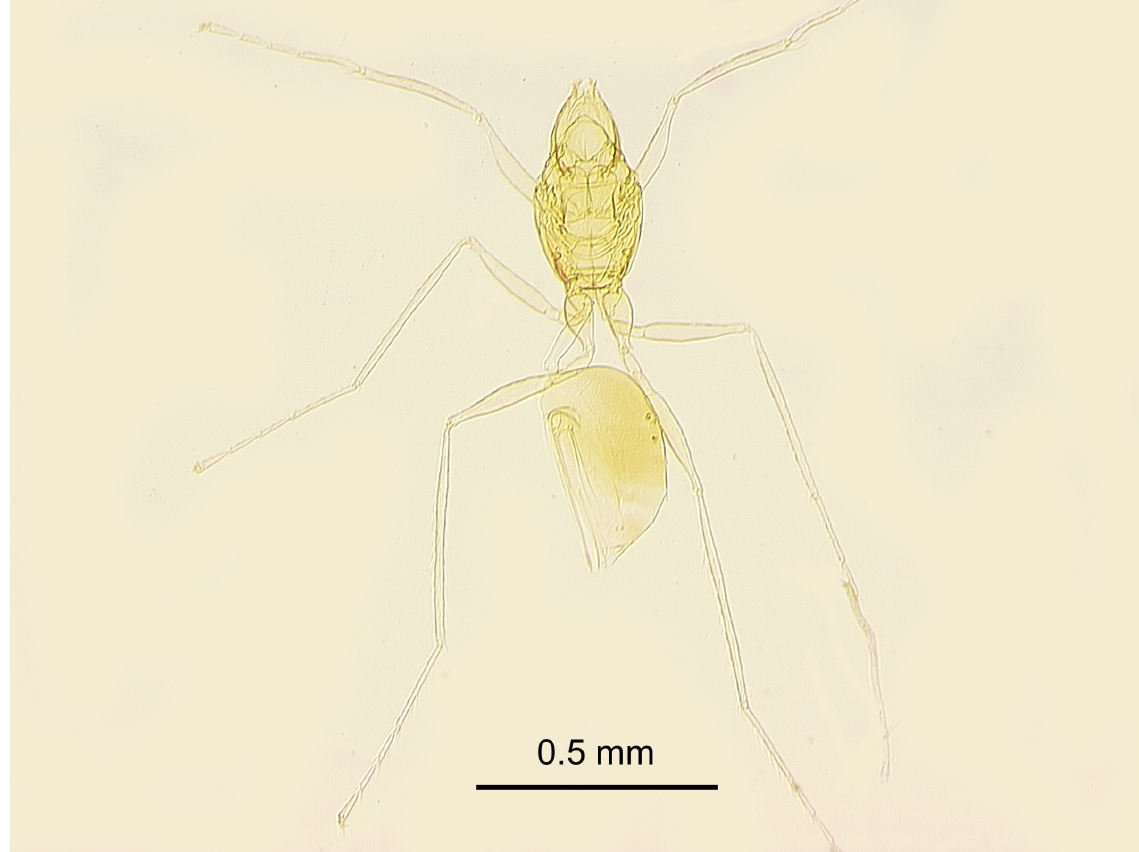
Fig. 15. Ganomymar zuparkoi sp. nov., ♀, holotype (CAS). Mesosoma, metasoma and